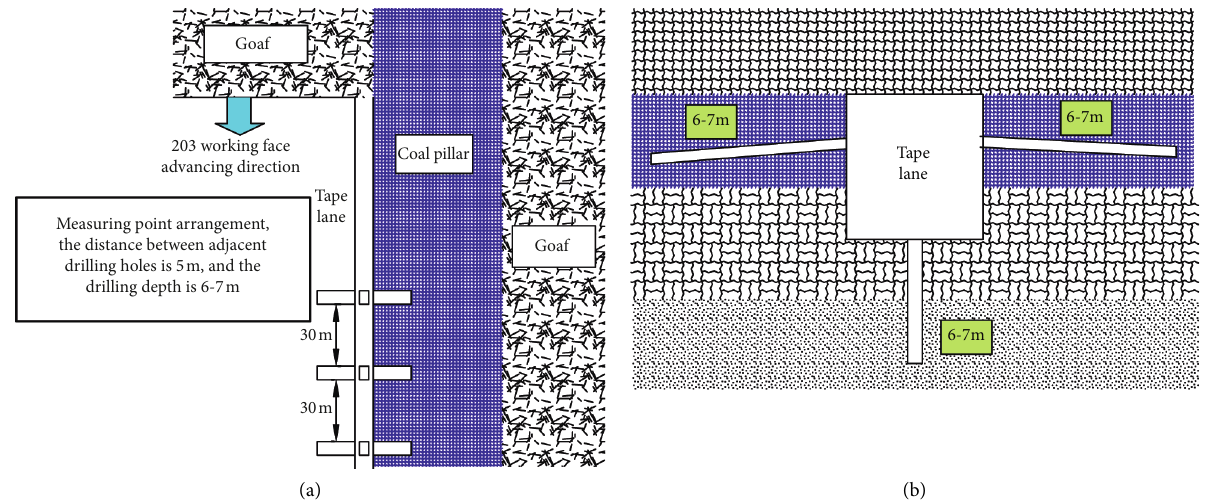
Figure 14: Plane section of borehole survey: (a) floor plan and (b)